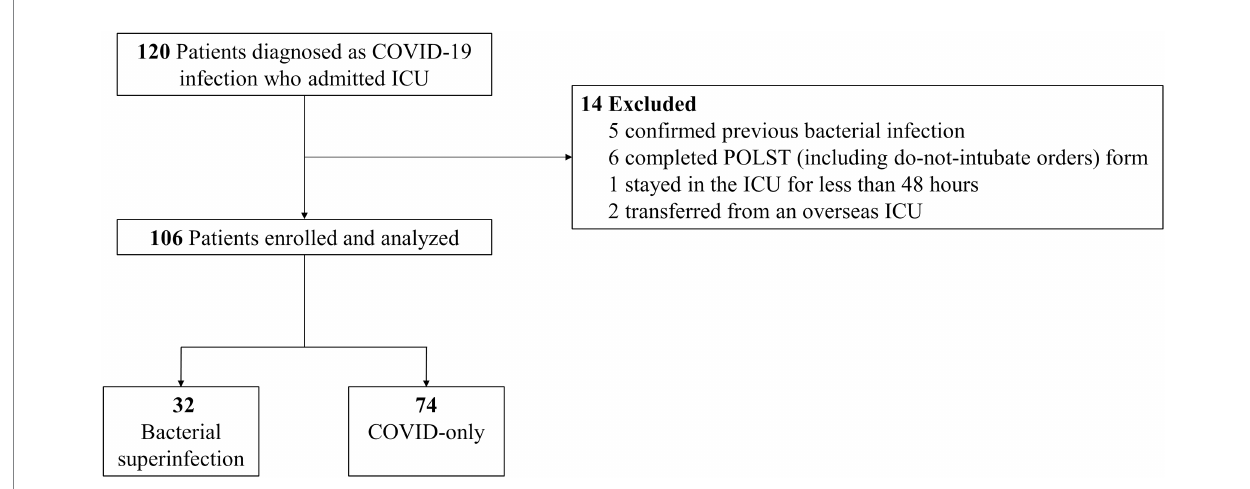
FIGURE 1 Flow diagram of the study population. POLST, portable orders for life-sustaining treatment; ICU, intensive care unit; COVID-19, coronavirus